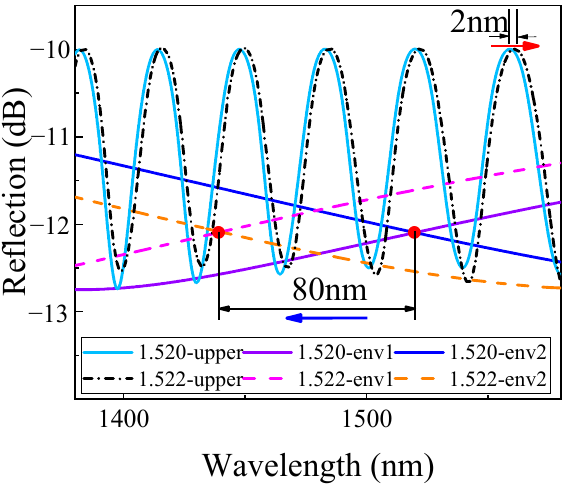
Figure 5. The spectral drifts when n2 changes from 1.520 to 1.522, and i = 4.